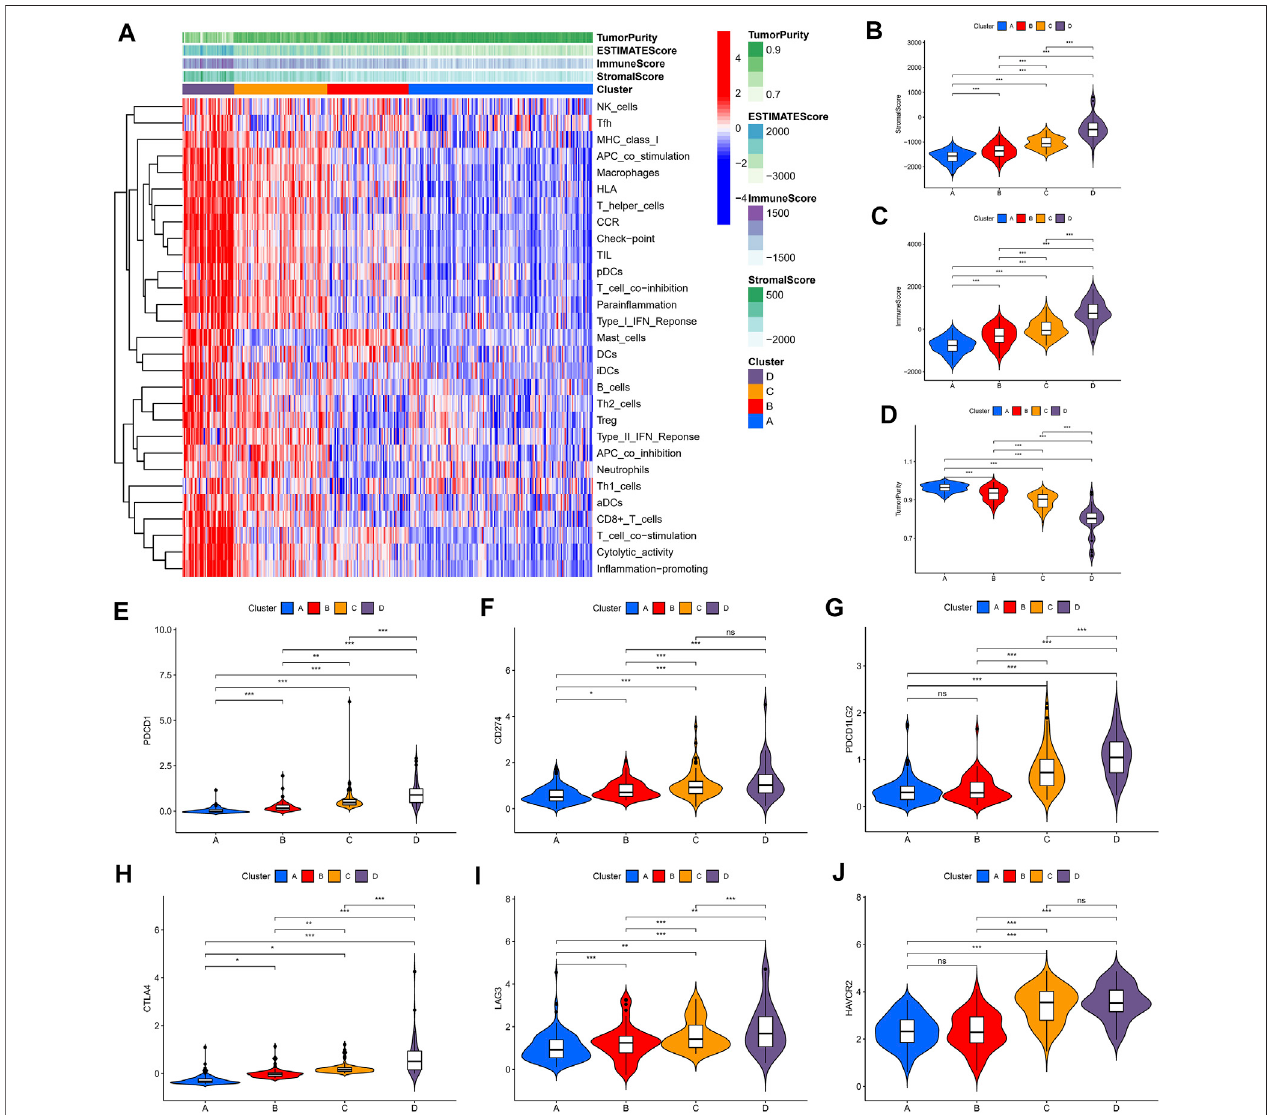
FIGURE 3 | Immune characteristics of the four clusters in the CGGA-1 dataset. (A) Heat map of the four immune clusters based on ssGSEA scores. (B) Stromal scores, (C) immune scores, and (D) tumor purity of different clusters. (E – J) Violin plots for the immune checkpoint gene expressions of PDCD1, CD274, PDCD1LG2, CTLA-4, LAG3, and HAVCR2 in different